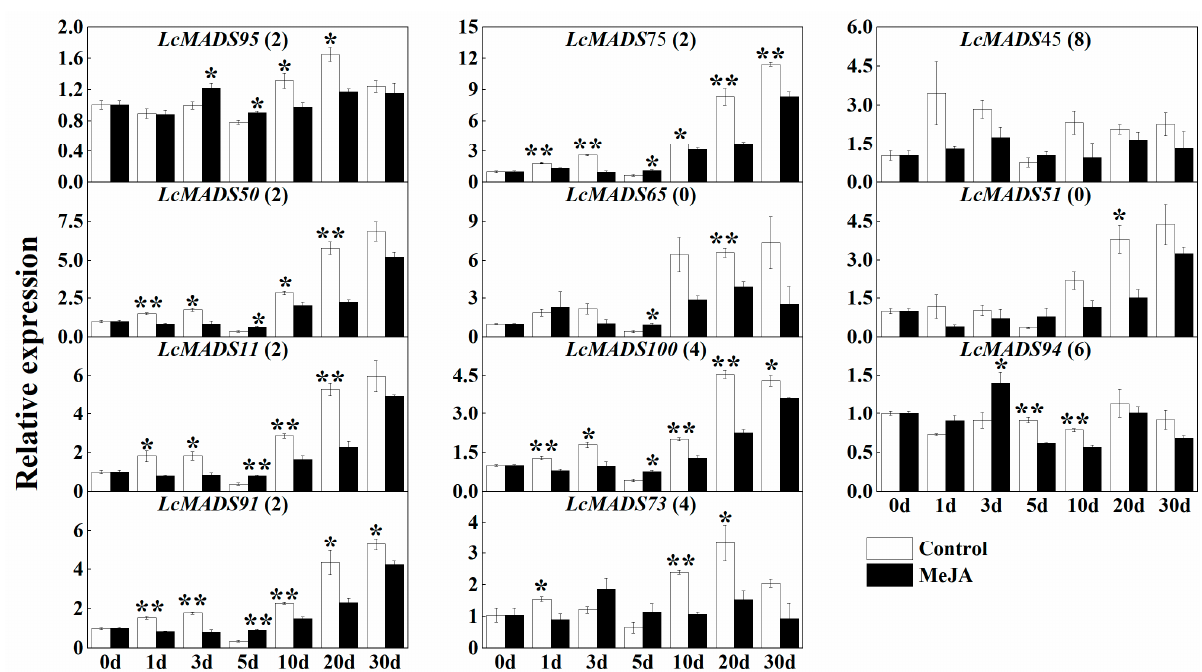
Figure 10. Relative expression of litchi MADS-box genes involved in the ABCDE model in response to treatment with MeJA. The number following the gene name indicates the number of predicted GA response elements in the promoter region. Data shown are mean ± SE of at least three biological replicates. Significant differences between treatments at each time point determined by an independent sample t -test are indicated with * ( p < 0.05) and ** ( p < 0.01).